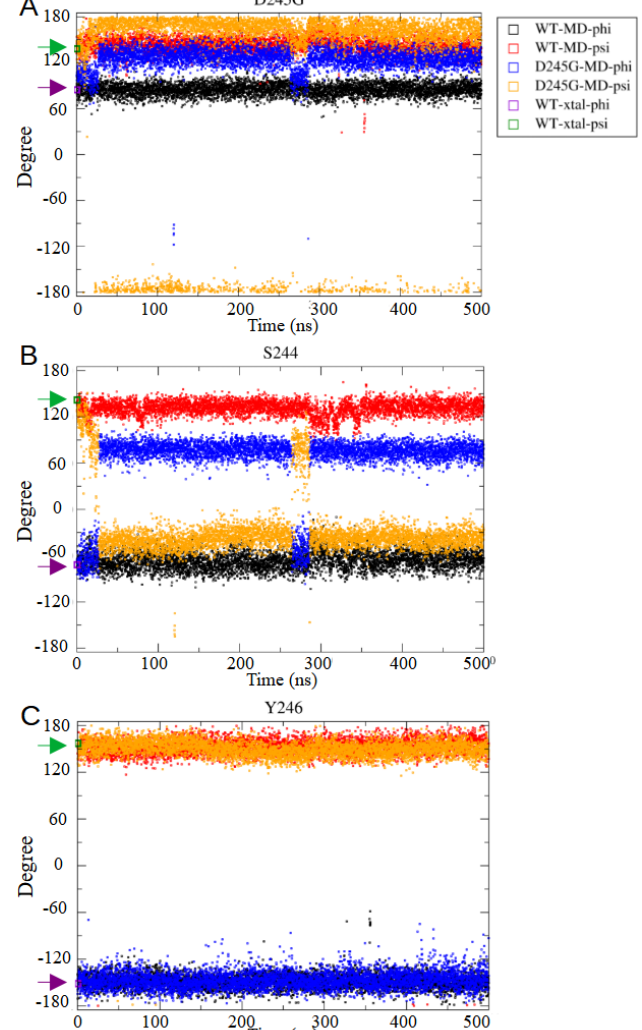
Figure 8. Dihedral angles of residue 245 and neighboring residues in the MD simulation of the WT and the D245G mutant. Dihedral angles of residues ( A ) 245, ( B ) 244, and ( C ) 246 in the MD simulation are shown for the WT (phi, black; psi, red) and the D245G mutant (phi, blue; psi, orange). Phi–psi angles in the crystal structure (xtal) are denoted as purple (phi) and green (psi) squares at x = 0 and highlighted by arrows.